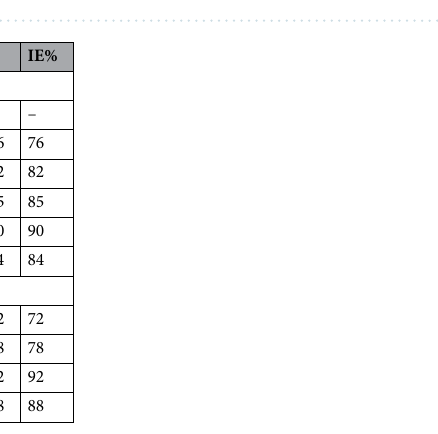
Table 2. Corrosion parameters derived from Nyquist curves for st-37 in H 2 SO 4 solution in the absence, and presence of different concentrations of inhibitor based on bulk, and nano size, at 25 ± 1 °C.